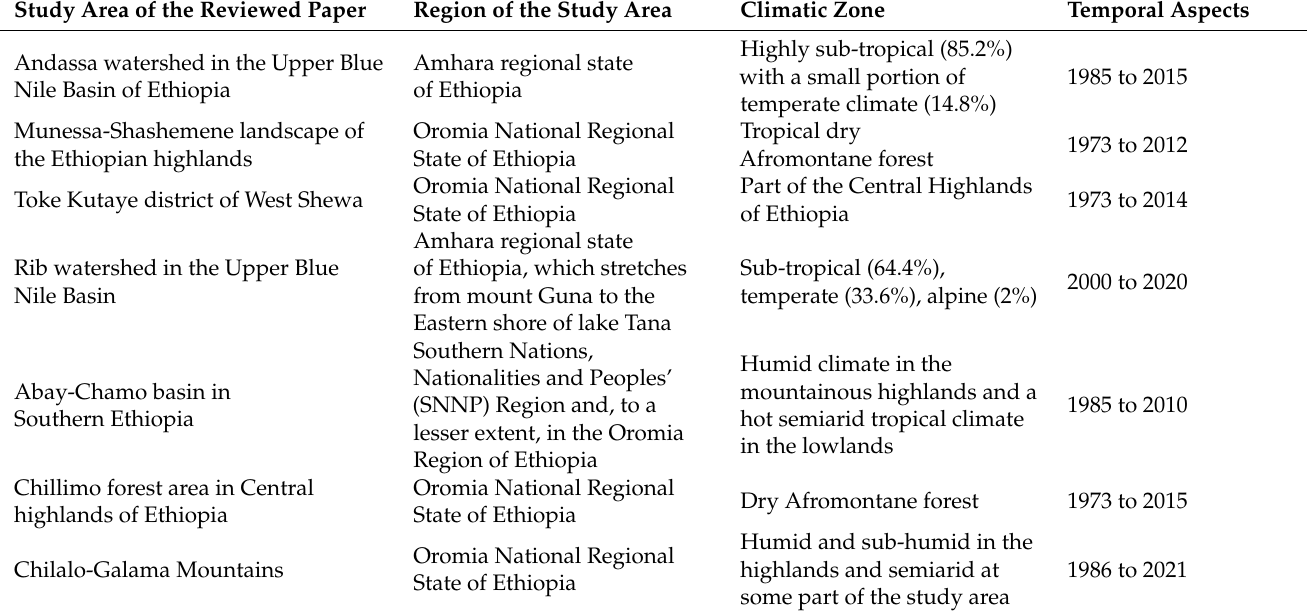
Table 1. Spatial and temporal distribution for the mountainous locations of the selected papers.